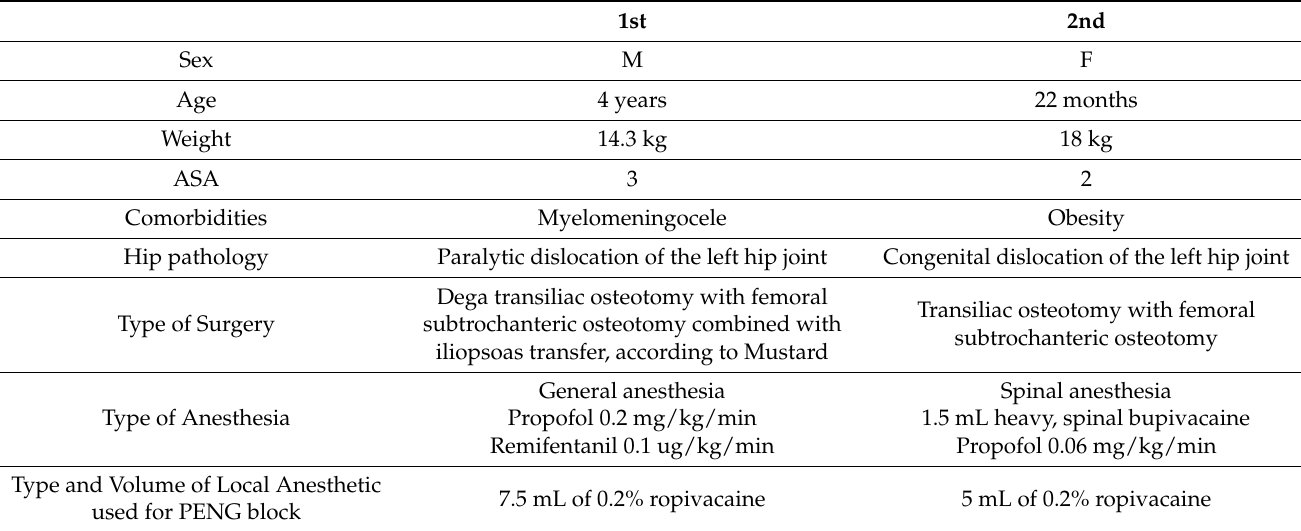
Table 1. Characteristics of